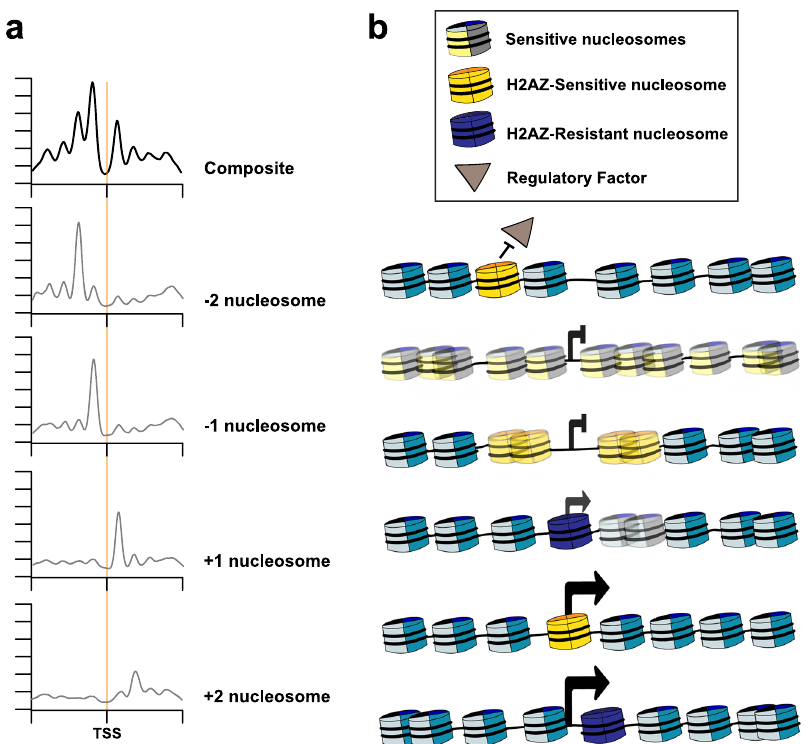
Fig. 8 A model depicting how H2A.Z regulates promoter chromatin architecture. a The current model for the arrangement of nucleosomes at a promoter is a composite of many different types of promoters with non-identical nucleosome occupancies at the − 2, − 1, + 1 and + 2 positions. b Multiple functions of H2A.Z at a promoter. H2A.Z may occupy transcription factor binding sites to prevent promiscuous transcription factor binding. Strongly repressed promoters are associated with poorly positioned micrococcal sensitive nucleosomes across the promoter or poorly positioned H2A.Z micrococcal sensitive nucleosomes at the − 1 and + 1 positions. Moderately repressed promoters contain a H2A.Z micrococcal resistant nucleosome at the TSS. Active promoters contain a micrococcal sensitive nucleosome at the TSS or a micrococcal resistant nucleosome at the + 1 position with the latter chromatin structure displaying the highest level of gene